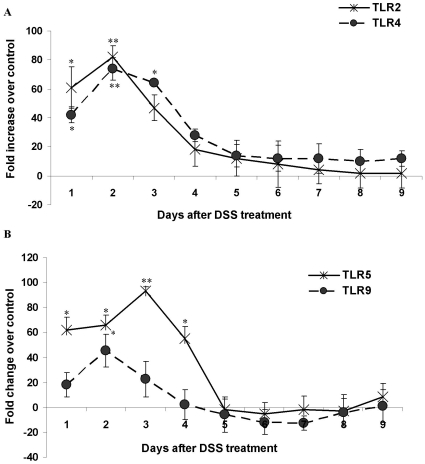
The effect of DSS treatment on the TLR gene expression.Relative gene expression of (A) TLR2 (asterisks) and TLR4 (circles) and (B) TLR5 (asterisks) and TLR9 (circles) genes in DSS treated rats over controls during 9 days of DSS treatment. The expression levels of TLR genes were determined by real time PCR and normalized using GAPDH as housekeeping gene. The mRNA levels are plotted as fold change over control. Data shown are the means ± SEM of 6 animals/day. *P<0.05 and **P<0.001 compared to control colon.